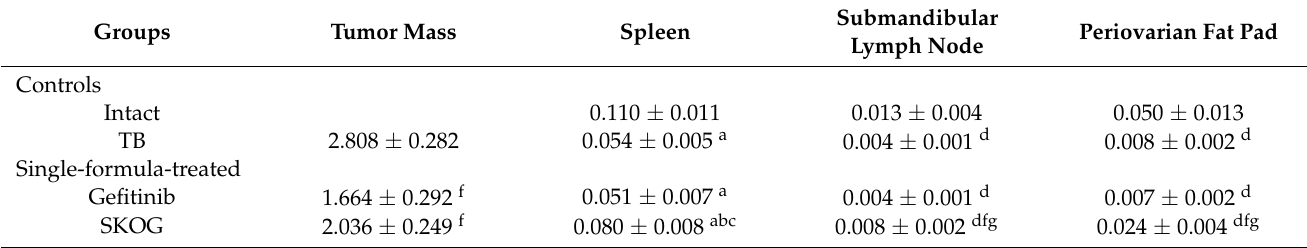
Table 3. Changes in the absolute tumor mass and organ weights in the NCI-H520 tumor cell xenograft